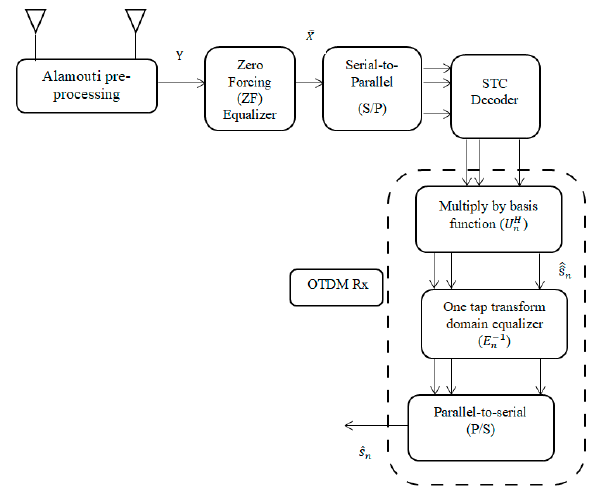
Figure 2. STC OTDM receiver technique.